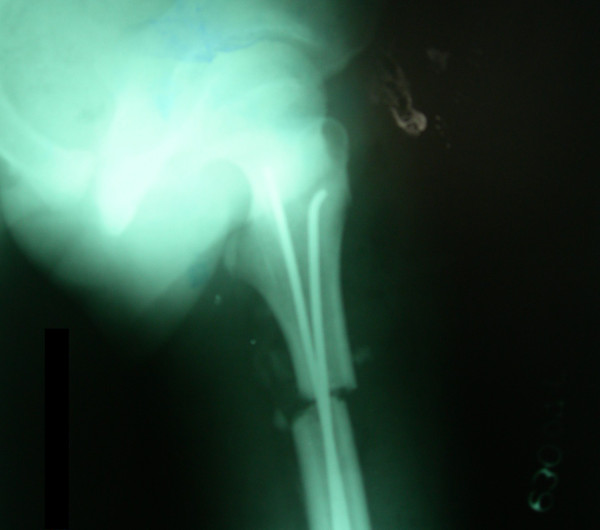
Lateral radiographs of a patient showing good nail position in proximal femur on immediate postoperative radiographs